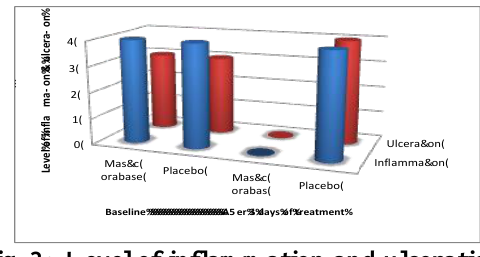
Fig. 2: Ulcer area size (mm 2 ) with days of trial of mastic orabase and placebo groups.